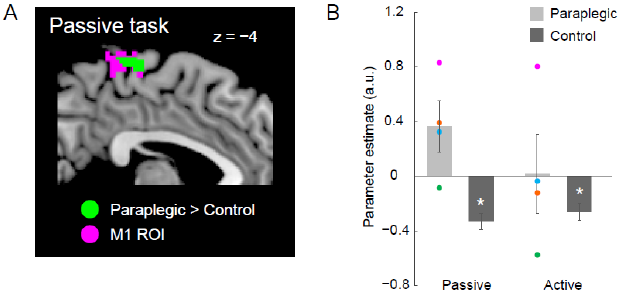
Figure 3. Results from the ROI analysis for M1. ( A ) Significant cluster in which the paraplegic group showed greater activity during the passive task than the control group (green section) within the M1 ROI (pink section). The cluster and the ROI are superimposed on the sagittal slice (x= − 4) of the MNI brain. ( B ) Bar graphs show mean value of brain activity (parameter estimate) obtained from the identified M1 cluster across participants for each task in both the paraplegic group (light gray) and control group (dark gray). Individual data from the paraplegic group are also plotted (pink, green, orange, and blue circles represent data obtained from P1, P2, P3, and P4, respectively). Lines on the bars indicate standard errors of mean across participants. Asterisks indicate a significant decrease of activity in the control group ( p < 0.001). Abbreviations: a.u., arbitrary unit; M1, primary motor cortex; ROI, region-of-interest.